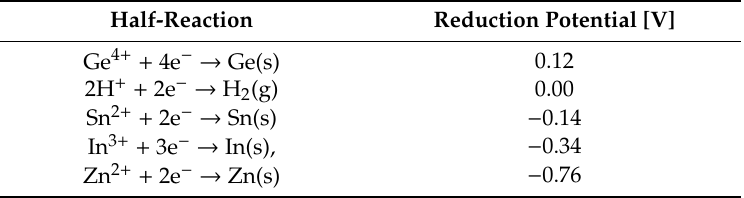
Table 1. Standard reaction potentials of germanium, tin, indium, and zinc [22].